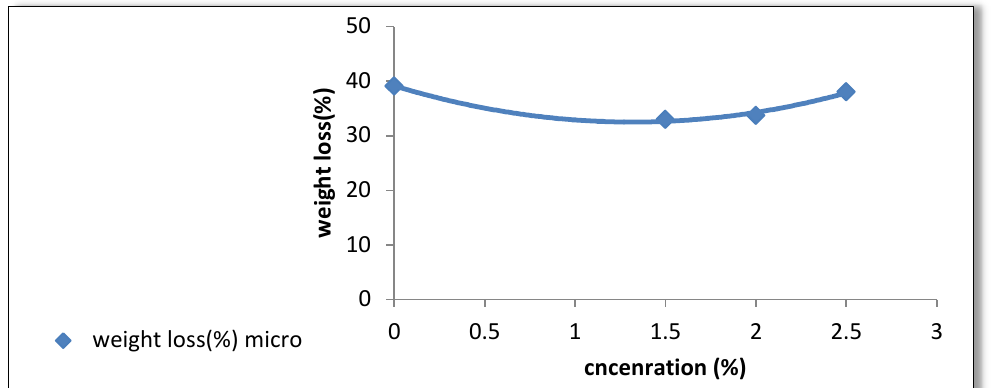
/St/PVA blend films. 2